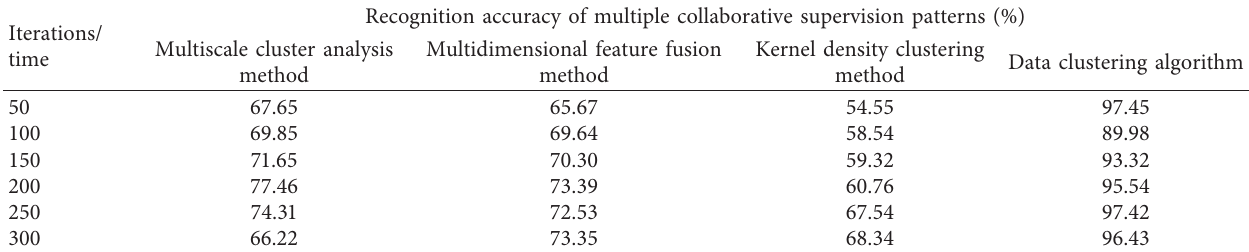
Table 1: Effectiveness of multiple collaborative supervision patterns recognition methods within social organizations. Iterations/